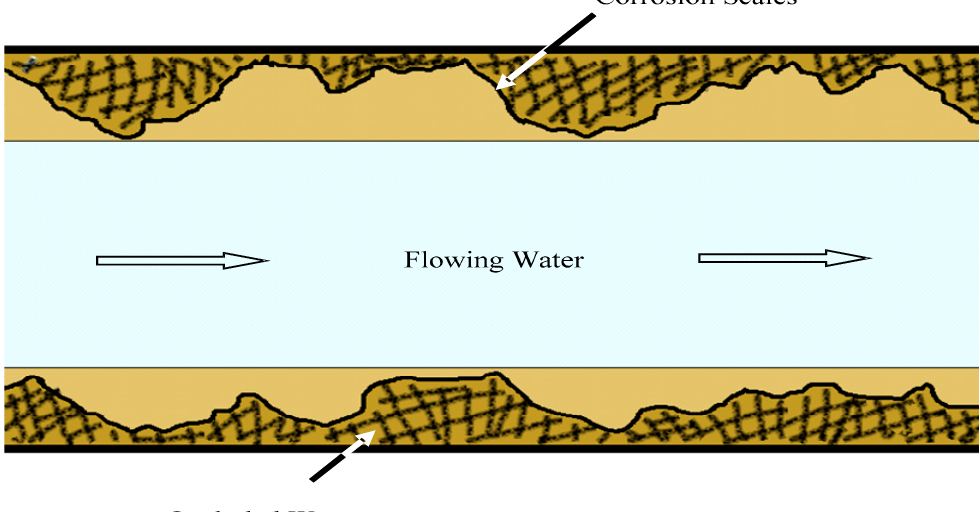
Figure 1. The idea of occluded water and flowing water in the corroded distribution pipe.